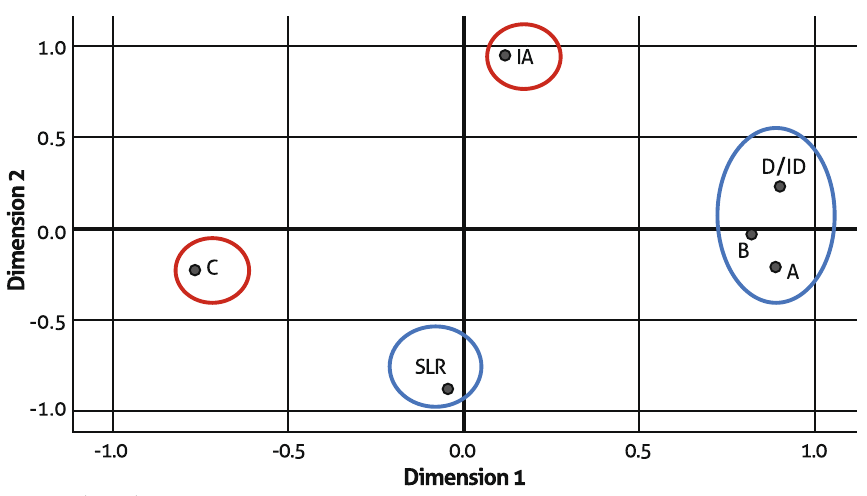
Fig. 9 A factor map (Source: the